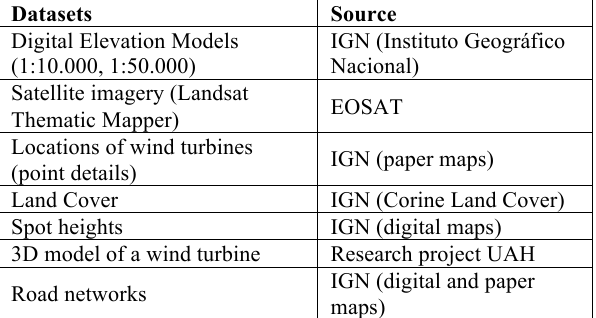
Table 3. Geographic datasets and data sources.